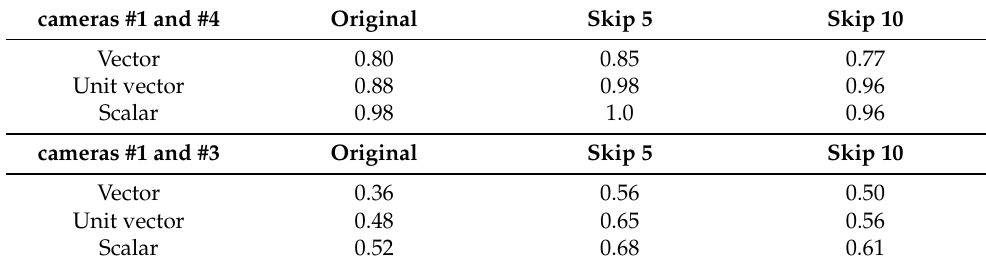
Table 4. F1 score for Global Tracklet Matching with Two Cameras for Five Persons and Ten Persons.